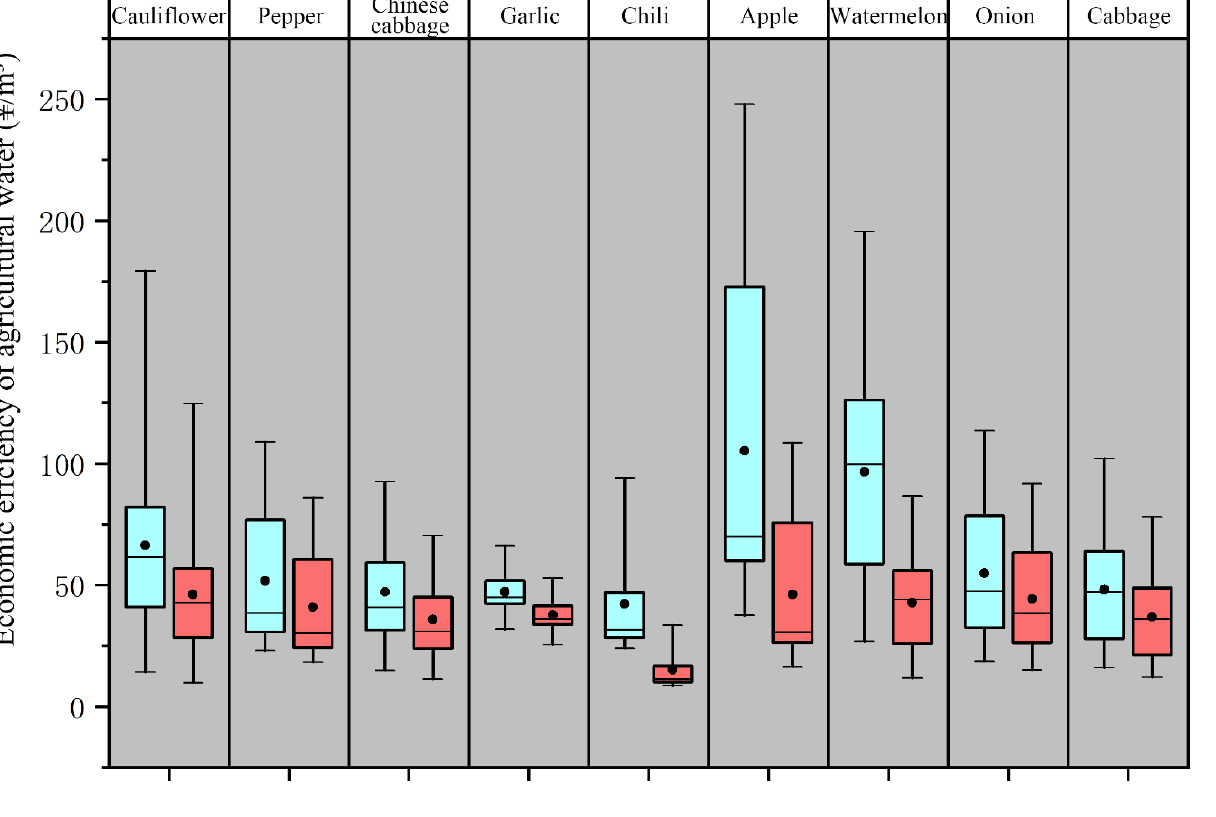
Figure 8. Box plots showing the 25th, 50th, and 75th percentiles and maximum and minimum values; black circle showing the median value, outliers are not shown in the figure. Blue box plots and red box plots represent economic efficiency of irrigation water and total water, respectively.